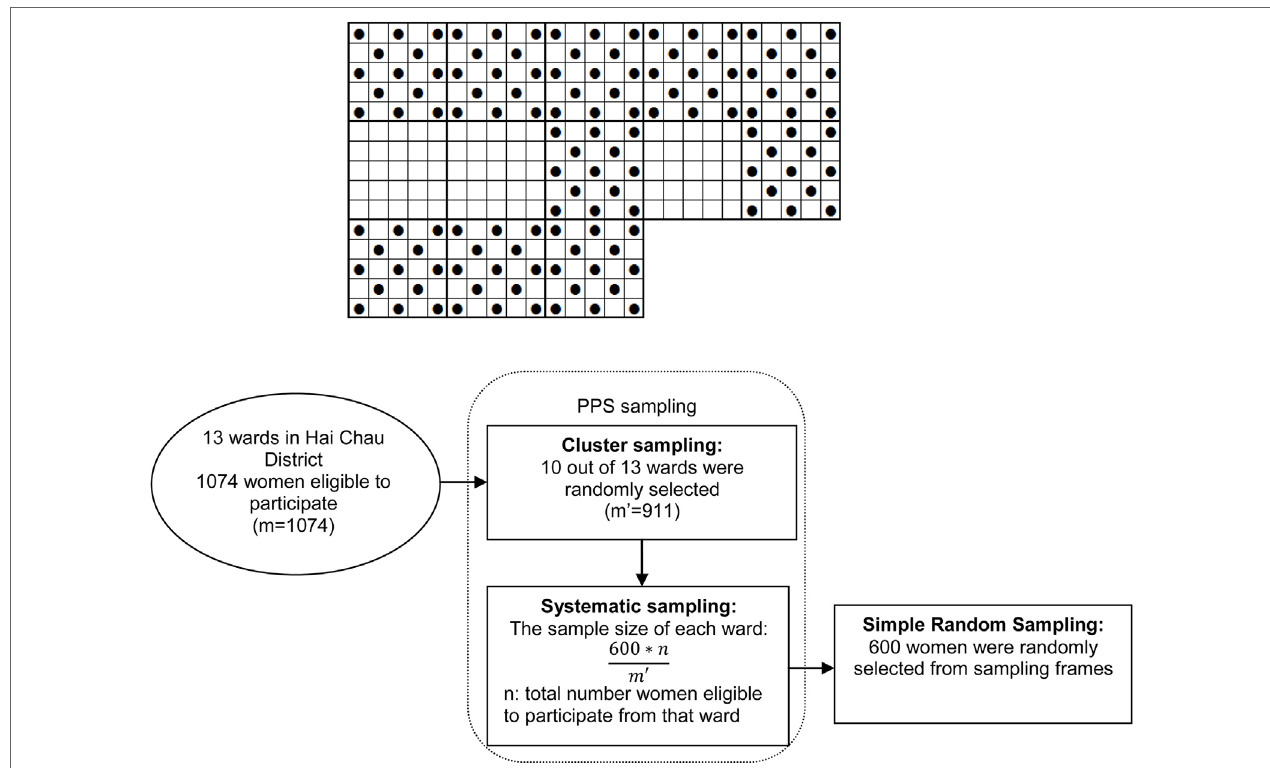
FigUre 1 | Two-stage sample (cluster then systematic) in the study